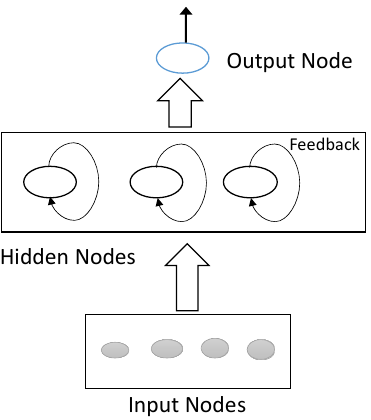
Figure 3. The architecture of a recurrent neural network model.